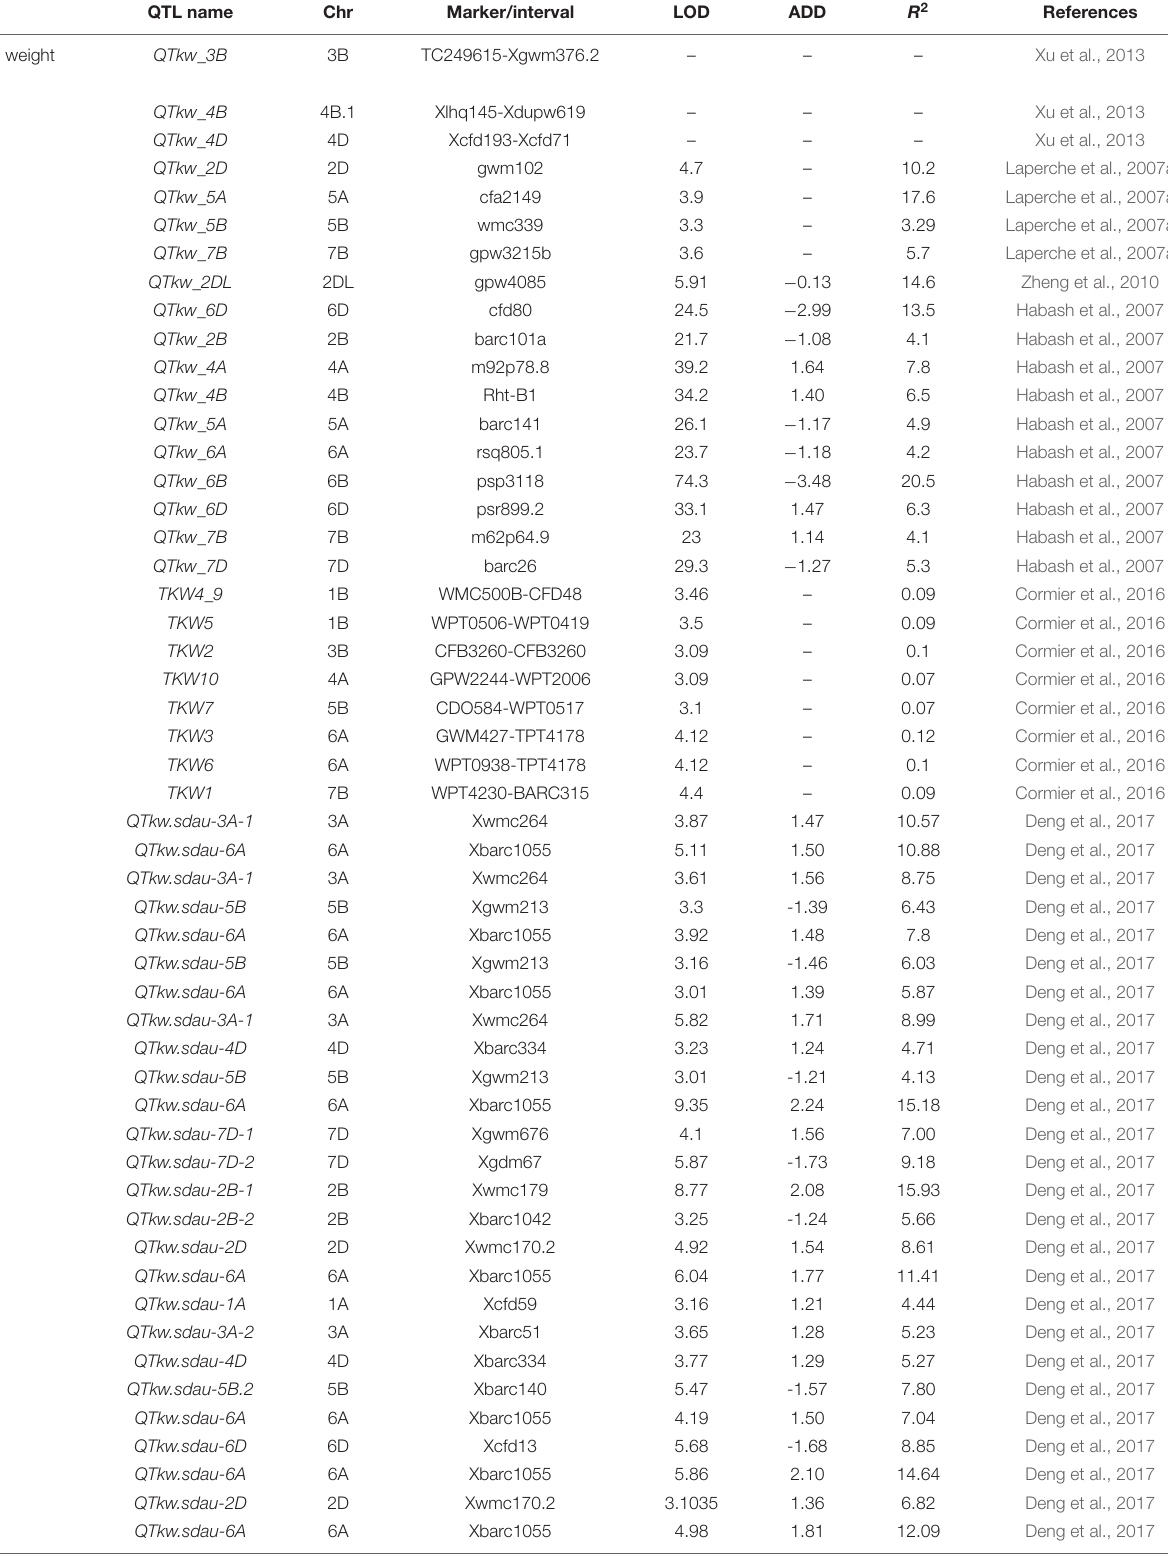
TABLE 3 | Detailed description of QTL associated with nitrogen use efficiency-related traits in wheat.